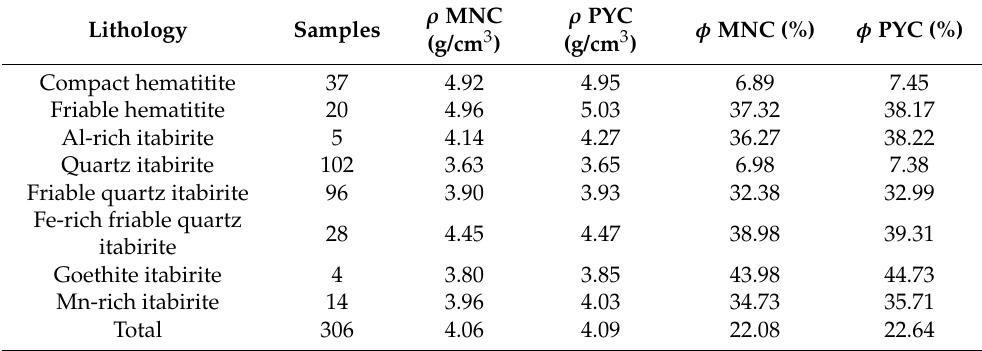
Table 2. Average mineral density ( ρ ) and porosity ( φ ) by lithology and measurement method— weathered samples—subgroups 1 (friable) and 2